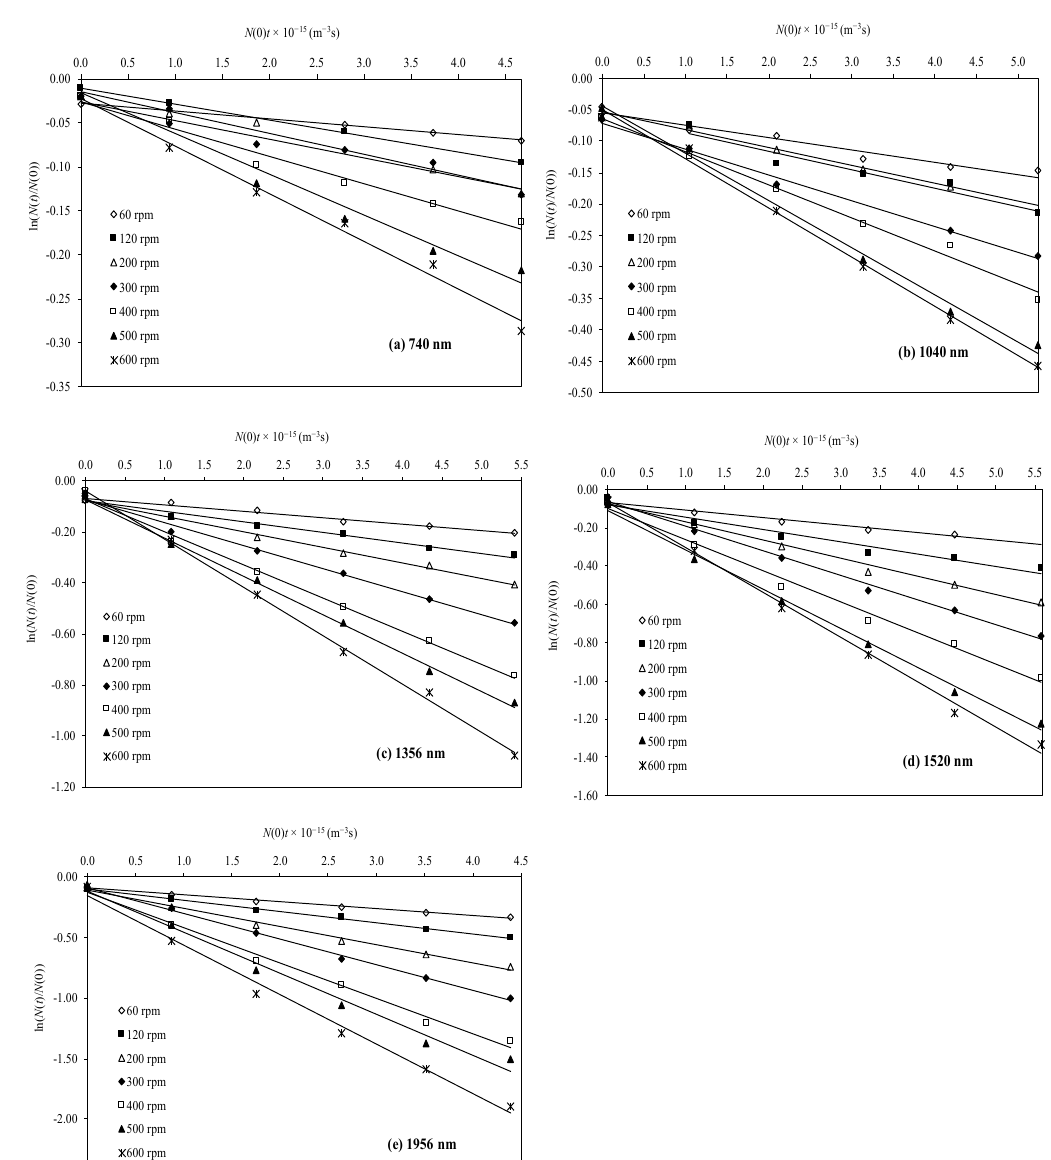
Figure 4. Temporal changes in the number concentration of colloidal particles of different diameters for different mixing intensities.